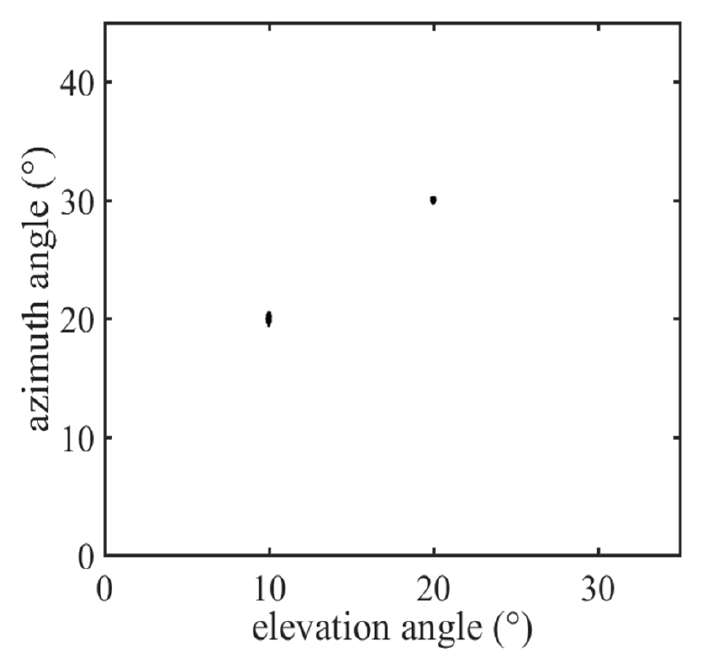
Figure 5. The scatter image of DOAs with TA ‐ MUSIC.